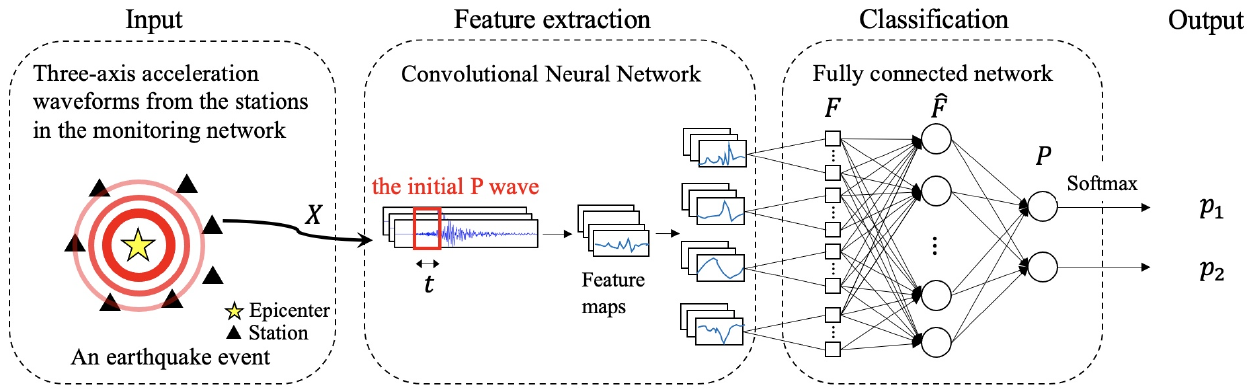
Figure 1. The proposed Intelligent Strong Motion Prediction (ISMP)